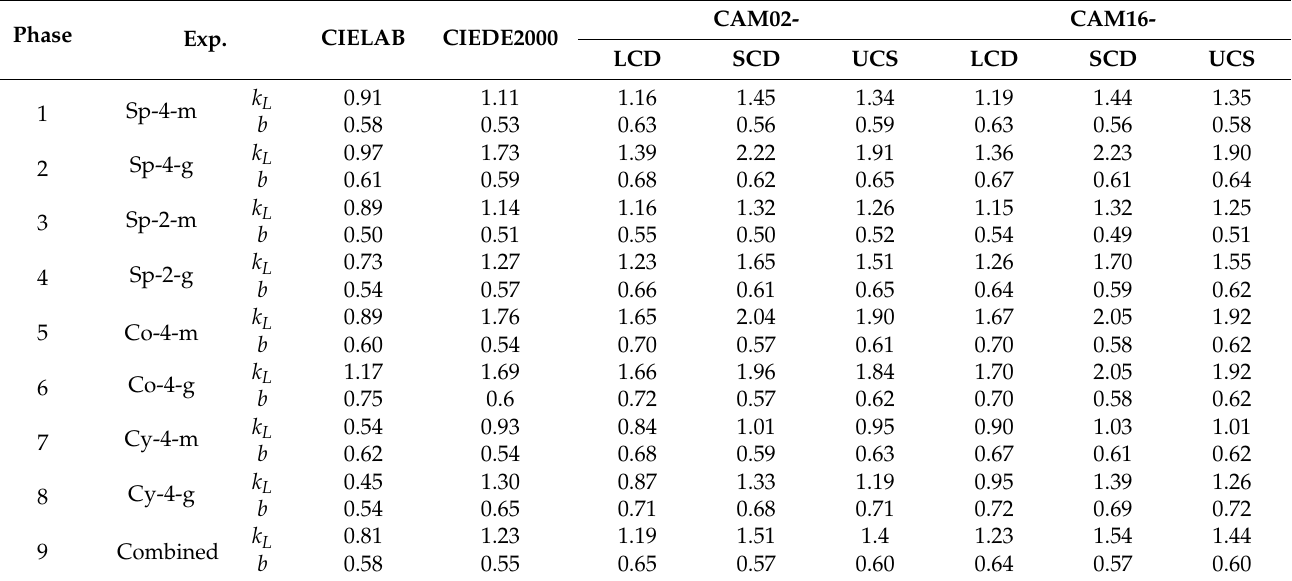
Table 9. Simultaneously optimized values of the lightness parametric factor k L and exponent b (power function) for the eight color-difference formulas and nine phases (Table 1) in the visual experiments in